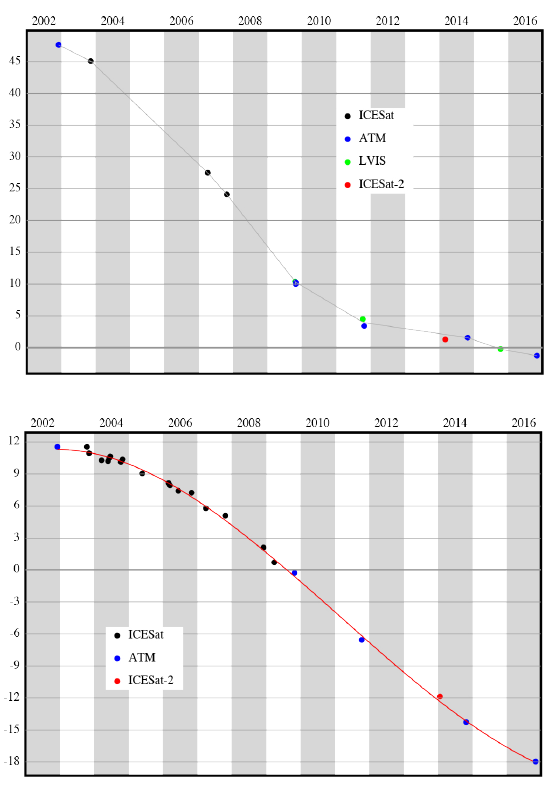
Figure 4: Elevation change time series from airborne (ATM, LVIS), spaceborne (ICESat) and simulated spaceborne (ICESat-2) laser altimetry data. The red dot marks the first pass of the simulated ICESat-2 data. Upper panel show elevation change near the grounding line, while lower panel refers to a location further